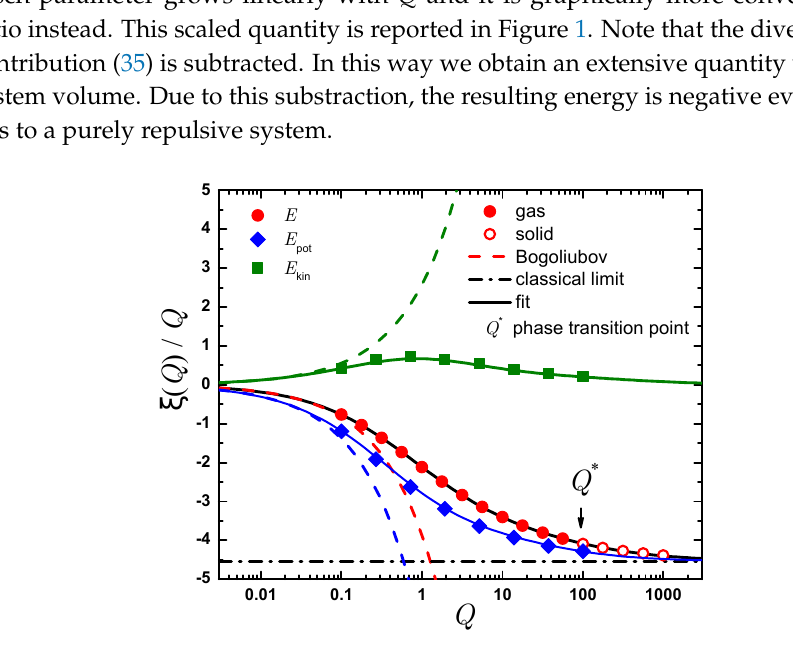
Figure 1. Bertsch parameter ξ ( Q ) extracted from the ground-state energy E scaled by NQ as a function of Q on a semi-logarithmic scale. Symbols are Monte Carlo results, solids lines are fits; dashed lines are asymptotic expansions. Including, solid circles, total energy in the gas phase; open circles, total energy in the solid phase; diamonds, potential energy; squares, kinetic energy; dashed lines, Bogoliubov theory prediction valid for small Q for the total (20), kinetic (54), and potential (53) energies; dash-dotted line, large Q limit of a classical fcc crystal (40) solid lines, fits given by Equation (46) for the total energy, Equation (51) for the potential energy and Equation (52) for the kinetic energy. The arrow shows the position of the gas-solid phase transition Q ∗ . The data points represent the energy of a gas for Q < Q ∗ and of a solid otherwise. Note that the jellium contribution is subtracted from the total and potential energies resulting in a negative energy even if the interaction is entirely